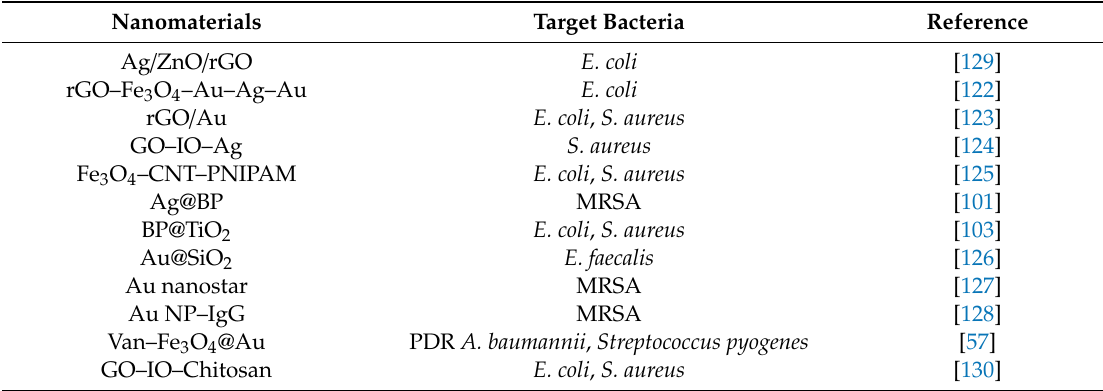
Table 2. Nanomaterial-mediated photothermal e ff ects on antibacterial